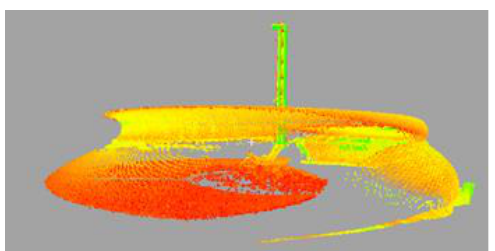
Figure 16. Three-dimensional laser scan before refraction correction for Trial 4 [36] (used with permission).